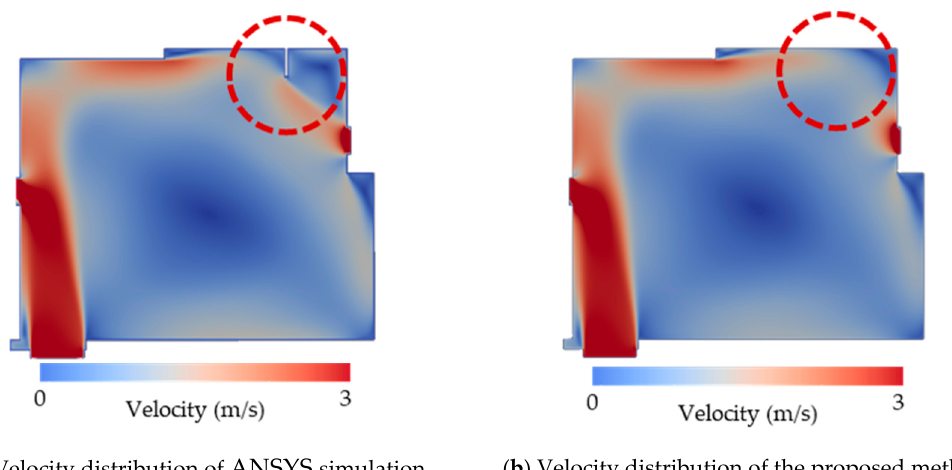
Figure 7. Difference in velocity distribution at D-type according to optimization.